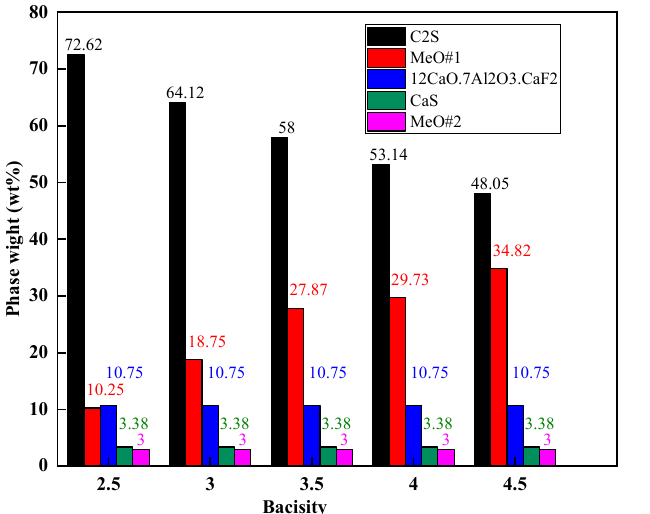
Figure 2. Relationship between the total amount of precipitation of each phase in the solid slag and the basicity. the